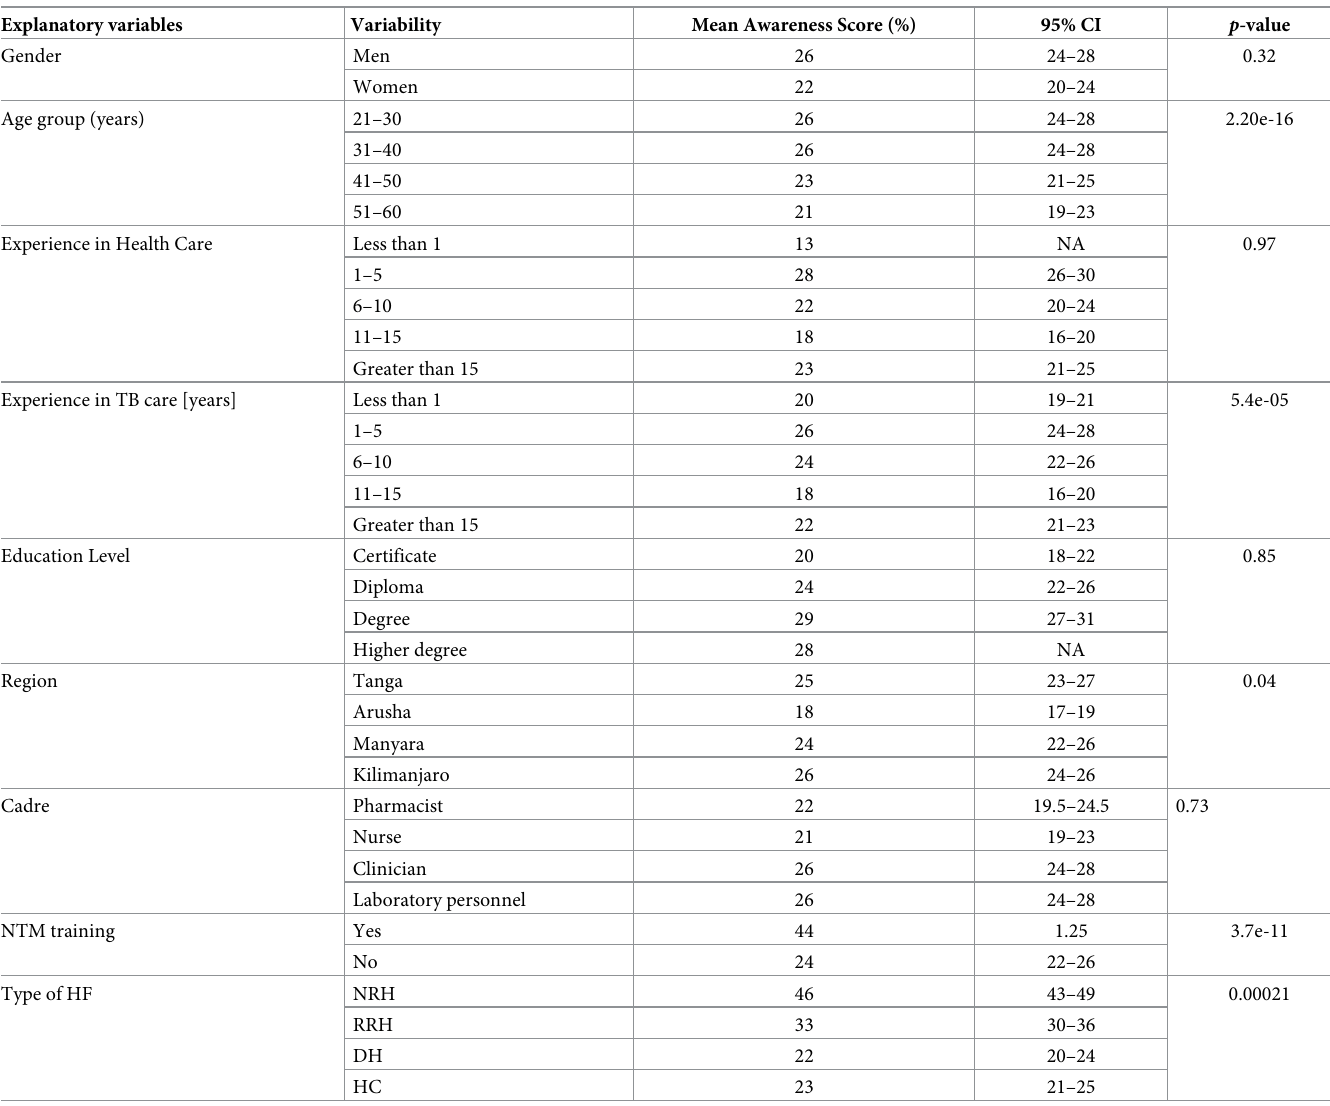
Table 3. NTM awareness score among study participants with different